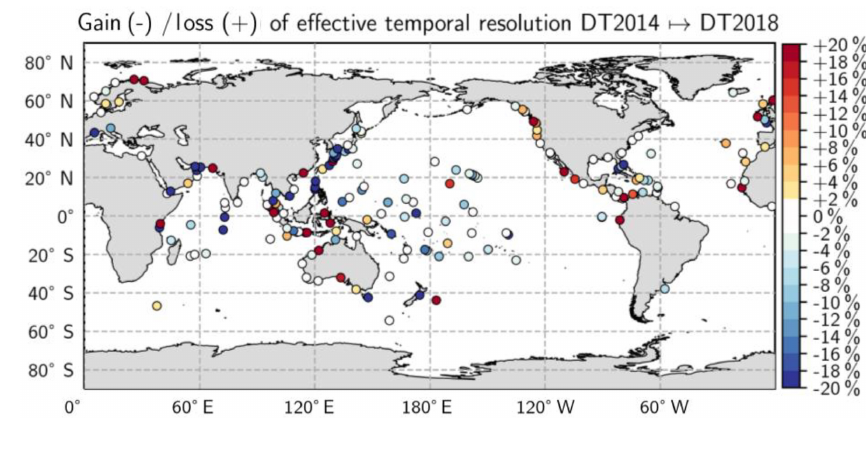
Figure 5. Gain/loss of effective temporal resolution between DT2018 and DT2014. Negative values mean that the resolution capability is better in DT2018 than DT2014.